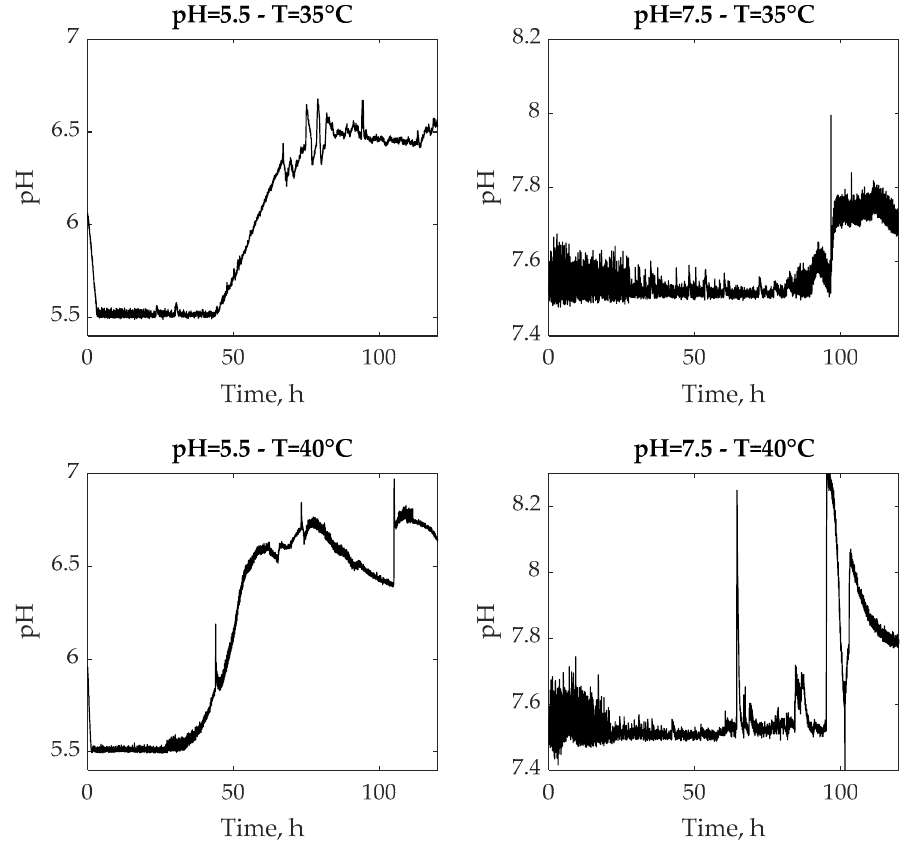
Figure 1. pH time series collected in the anaerobic treatment of raw cheese whey at different conditions of initial pH and temperature.